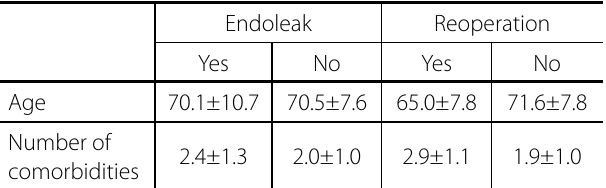
Table 2. Mean and standard deviations for age and number of comorbidities of patients evolving with and without endoleaks and those with and without reoperation.